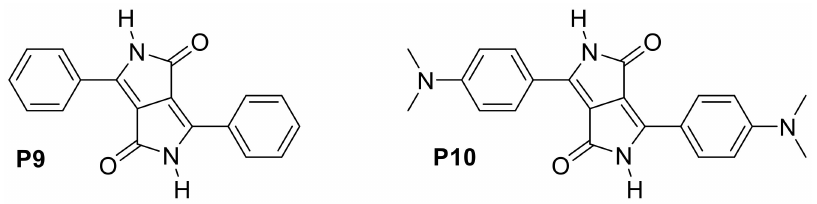
Figure A10. Diketo-pyrrolopyrroles.